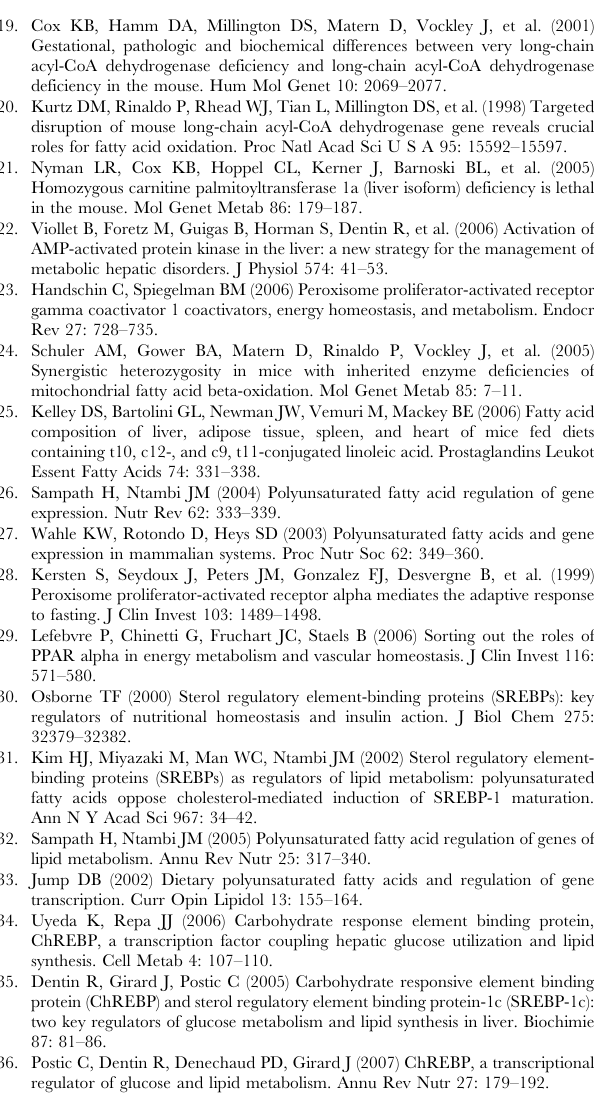
Figure S1 Urine dicarboxylic acid profiles. Urine of the wild type (dotted line) and Decr 2 / 2 mice (solid line) was collected for 24 h (fed sample) and collection was continued for 24 h after food removal (fasted sample). Pooled samples (5 mice/group) were normalized to urine creatinine and analyzed with mass spectrom- etry using tetradecanedioic acid (C14:0) as a reference. (A) Urine dicarboxylic acid profile without fasting. (B) Urine dicarboxylic acid profile after fasting. Table S1 Amino acid analysis from sera of fasted mice. Sera of the wild type and Decr 2 / 2 mice were collected after 24 h fast. Amino acids were analyzed by the clinical laboratory of the University Hospital of Oulu, Finland. The concentrations are expressed as means 6 SEM of 4 mice of each genotype per group. Table S2 Urine dicarboxylic acid analysis. Urine of the wild type and Decr 2 / 2 mice (5 mice/group) was collected for 24 h (fed sample) and collection was continued for 24 h after food removal